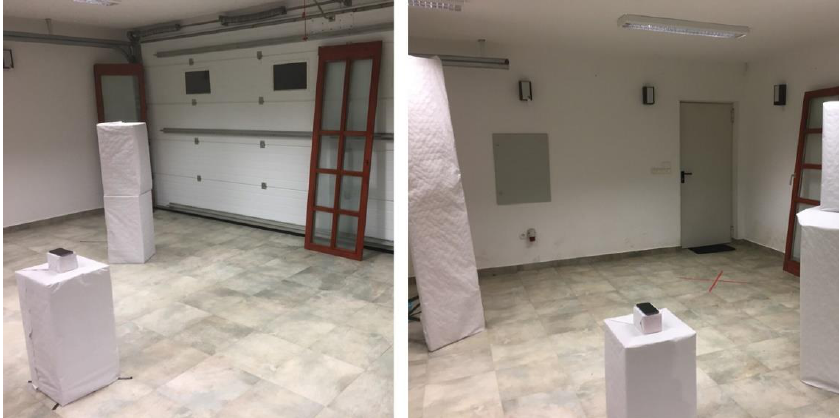
Figure 7. Testing environment with a high level of obstacle severity. Figure 5. Testing environment with a high level of obstacle